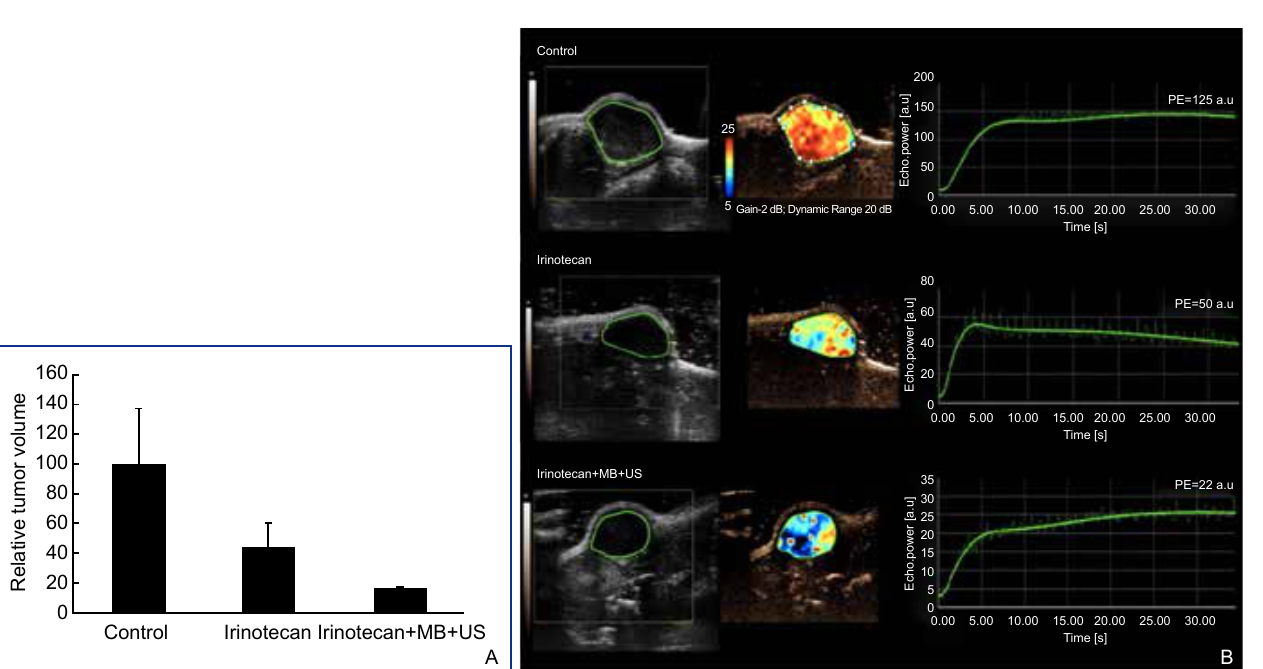
Figure 6 Effect(s) of in vivo irinotecan delivery using microbubble-assisted ultrasound on tumor volume (A) and perfusion (B) at day 39 after treatment. Tumor dimensions and perfusion were measured using anatomical and contrast-enhanced ultrasound imaging, respectively, in control, irinotecan treatment on its own, or using microbubble-assisted ultrasound groups. Data expressed as mean ± SEM were calculated from 10 tumors. (Reprinted with permission from reference